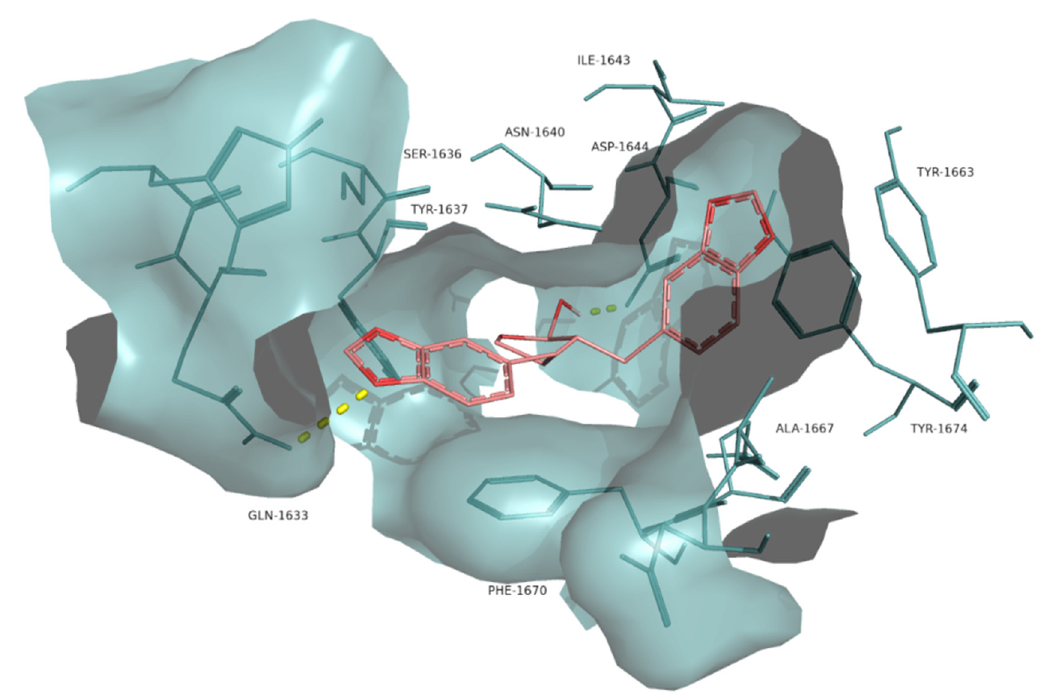
Figure 6. Molecular interactions of the best docking position of α -cubebin against Pks13. Hydrogen bonds are evidenced with yellow dashed lines.